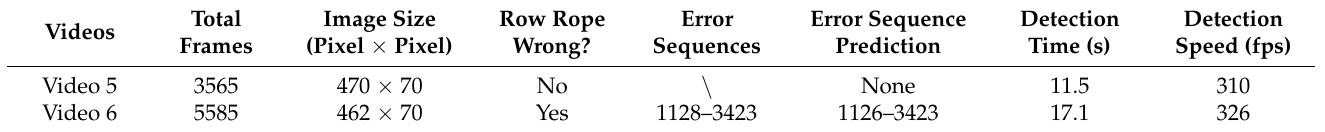
Table 7. The specific parameters of the videos and the results of